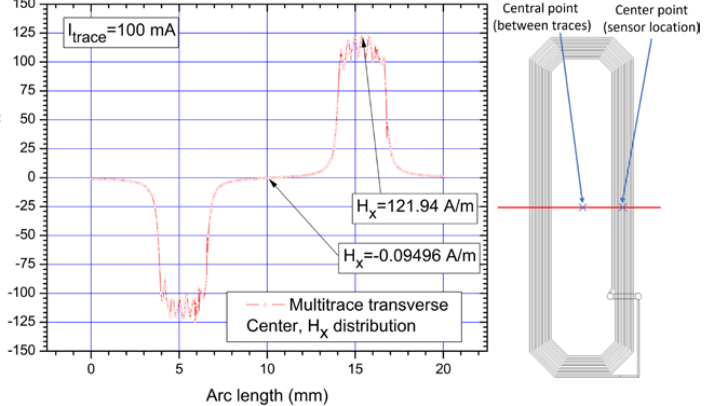
Figure 19. Magnetic field intensity on the x direction, variation for the Multitrace planar coil with 7 traces at height h = 80 μm from the trace according to results from COMSOL simulation: transverse center line (note the inset).